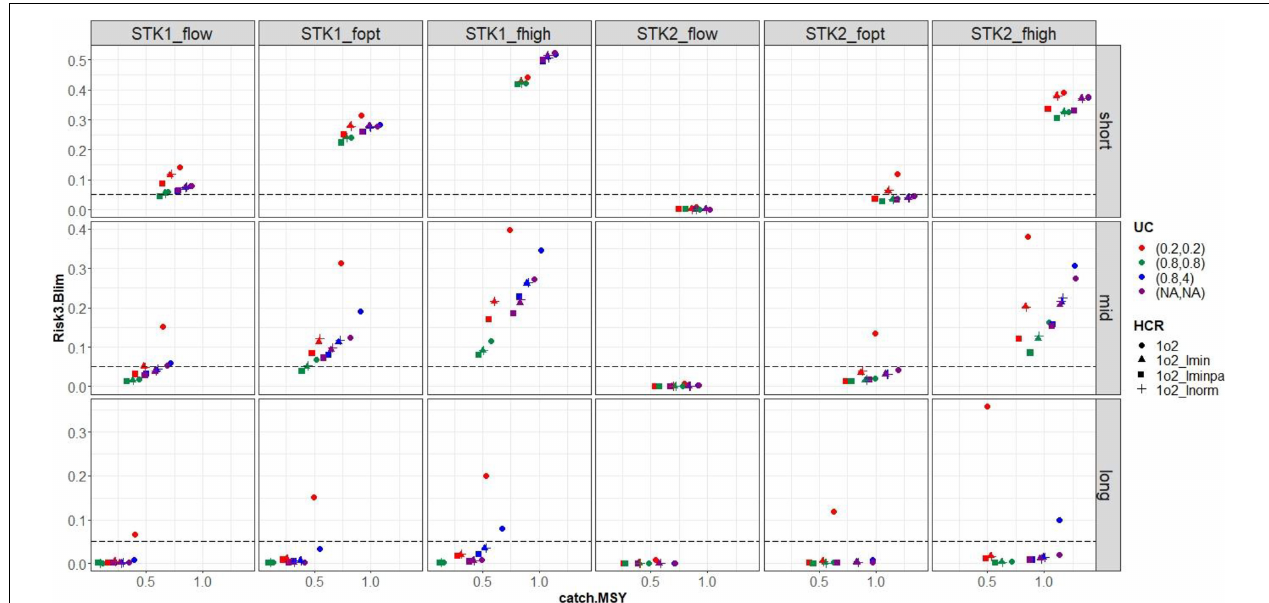
FIGURE 9 | Biological risks (Risk3.Blim: maximum probability of falling below B lim ) versus the relative yields (catches/MSY) (x-axis) for the 1-over-2 rule by uncertainty cap lower and upper limits (colours) and biomass safeguards (colours). The columns correspond to the different OMs (as combination of the stock-type and historical exploitation) and the rows to the temporal scales: the short-term (first 5 projection years), medium-term (next 5 projection years) and the long-term (last 10 projection years). Dashed line corresponds to the 0.05 risk. See Table 1 for definitions of abbreviations. Interactive version of the figure is available online at